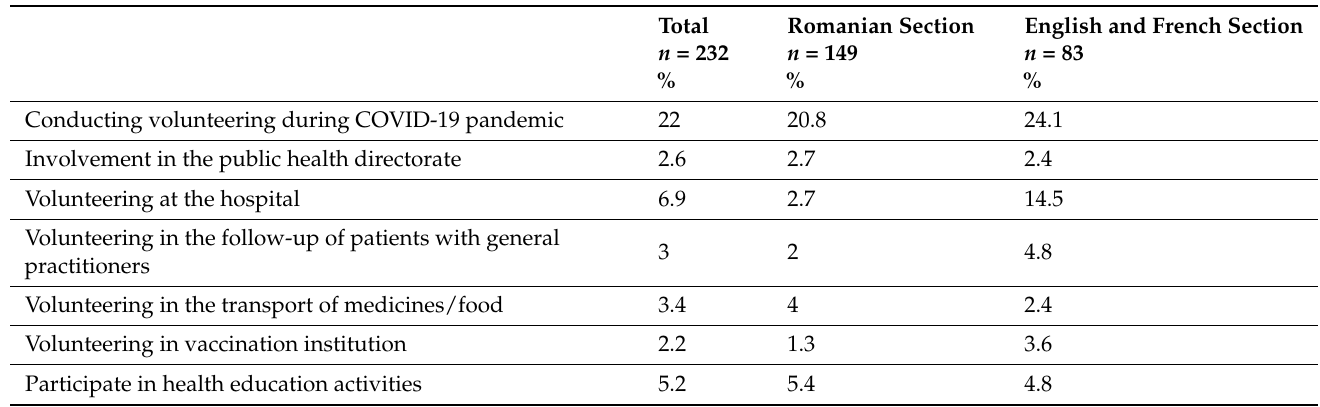
Table 2. Impact of COVID-19 pandemic regarding volunteering activities conducted by students in their final year.